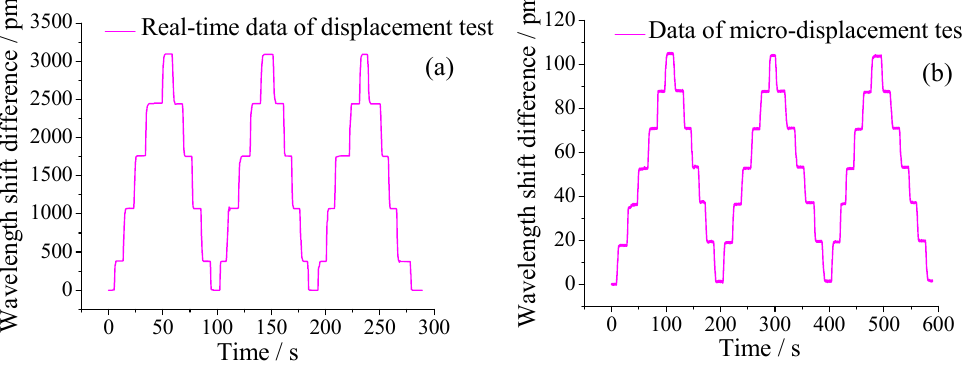
Figure7. Time-history curve of three cycling tests: ( a ) Range of 0~90 mm; ( b ) Range of 0~3 mm.